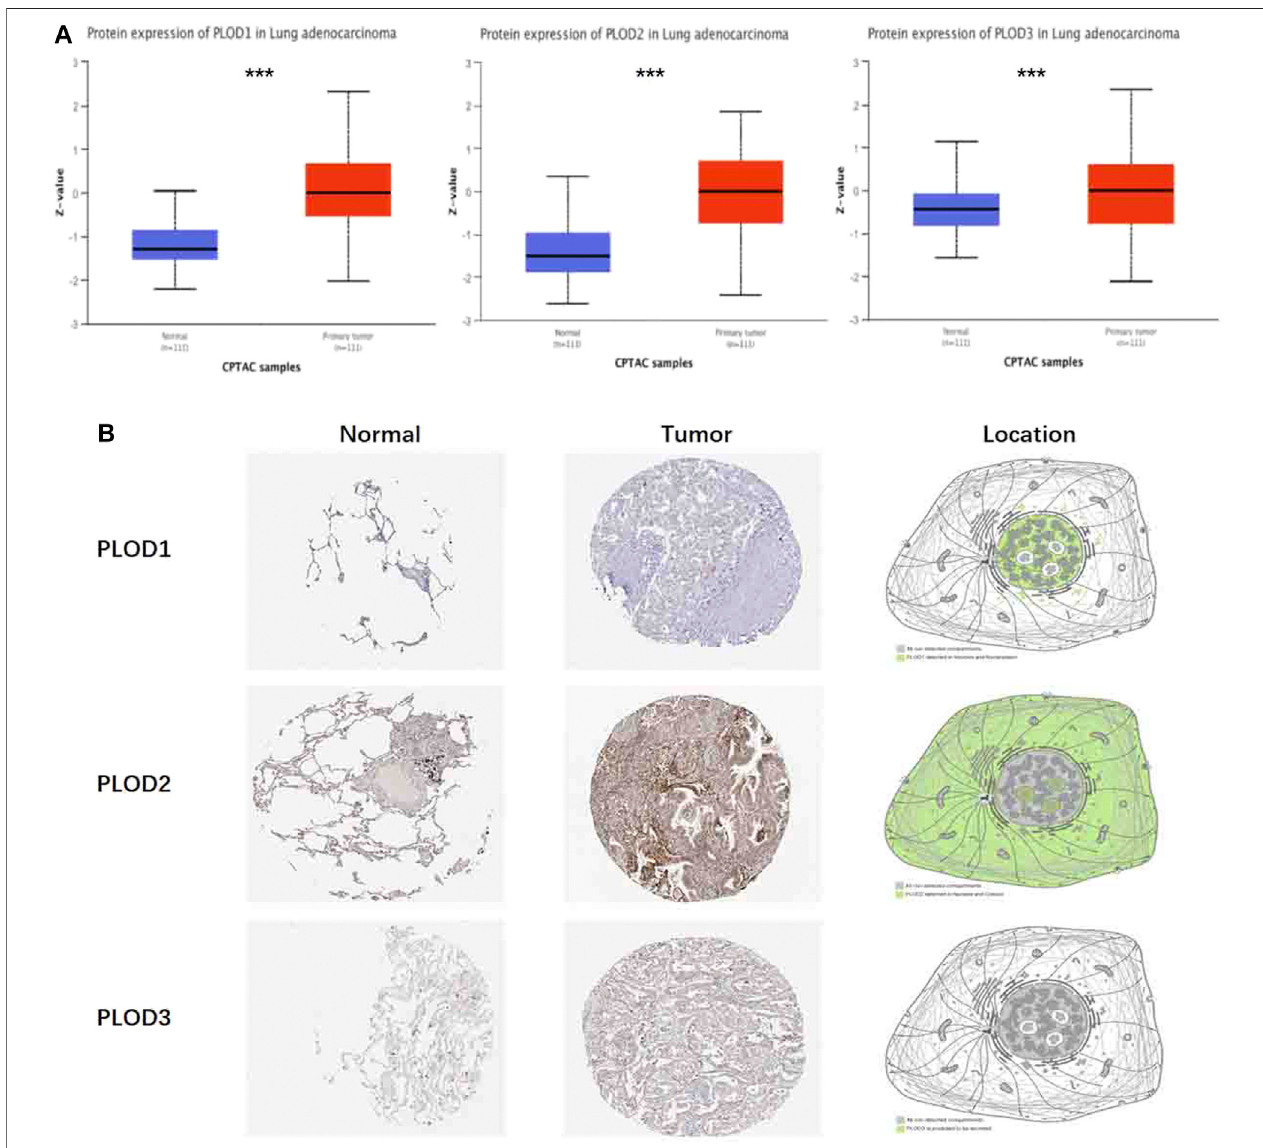
FIGURE3| Proteinpathologicalexpressioninlungtissue.Tofacilitateaccesstotheproteinexpressionof PLOD1 , PLOD2 ,and PLOD3 inLUAD,CPTACdatawere integratedwiththeUALCANdataportal (A) ,andthedifferentialexpressionandlocationof PLOD1-3 wereobservedintheHPA(*** p < 0.001) (B) . PLOD1 :normaltissue, https://www.proteinatlas.org/ENSG00000083444- PLOD1 /tissue/lung; tumor tissue, https://www.proteinatlas.org/ENSG00000083444- PLOD1 /pathology/lung + cancer. PLOD2 : normal tissue, https://www.proteinatlas.org/ENSG00000152952- PLOD2 /tissue/lung; tumor tissue, https://www.proteinatlas.org/ ENSG00000152952- PLOD2 /pathology. PLOD3 : normal tissue, https://www.proteinatlas.org/ENSG00000106397- PLOD3 /tissue/lung; tumor tissue, https://www. proteinatlas.org/ENSG00000106397- PLOD3 /pathology/lung + cancer.